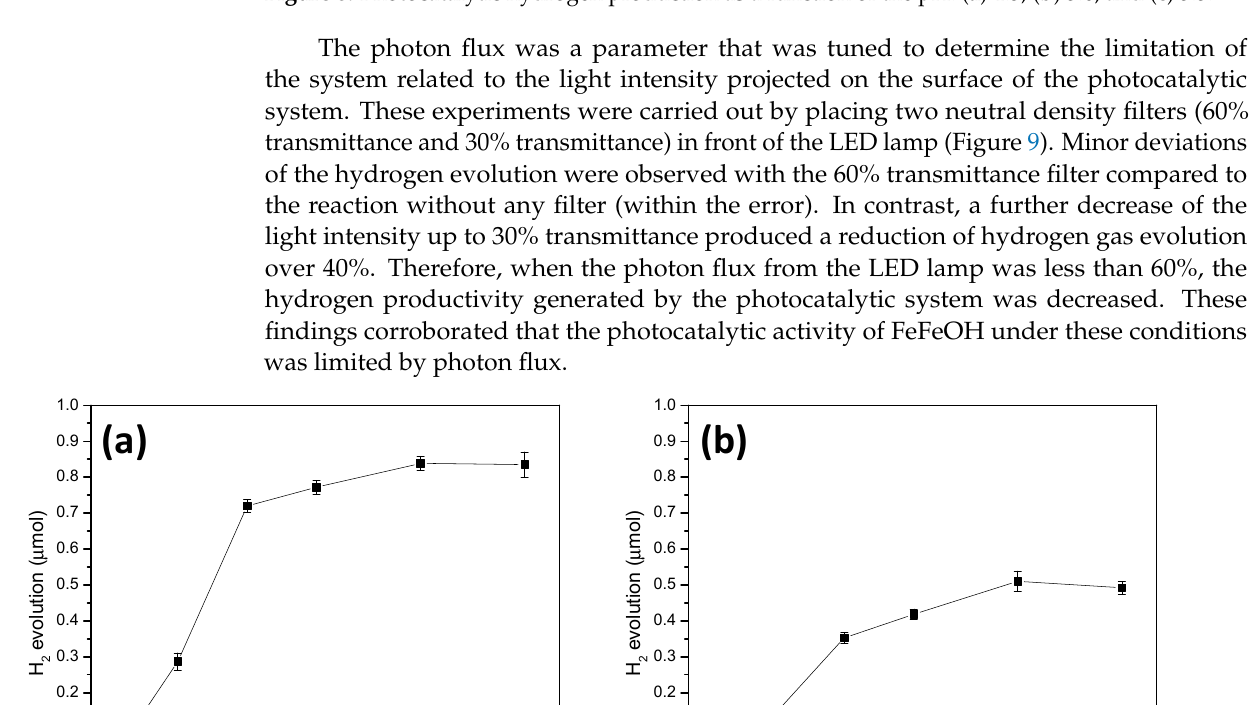
Figure 8. Photocatalytic hydrogen production as a function of the pH: ( a ) 4.5; ( b ) 5.0; and ( c ) 5.5.